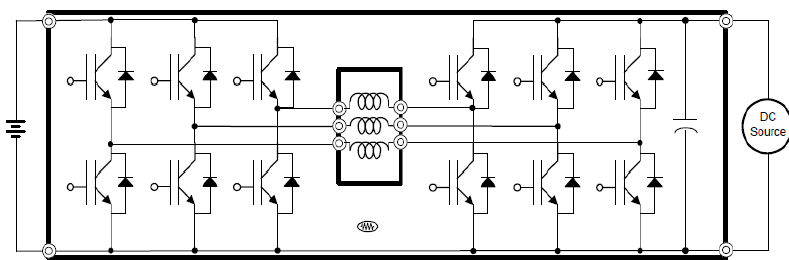
Figure 1. Single-phase bidirectional buck/boost topology. Energies 2017 , 10 , 1389 3 of 14 Figure 2. Three-phase bidirectional buck/boost topology.